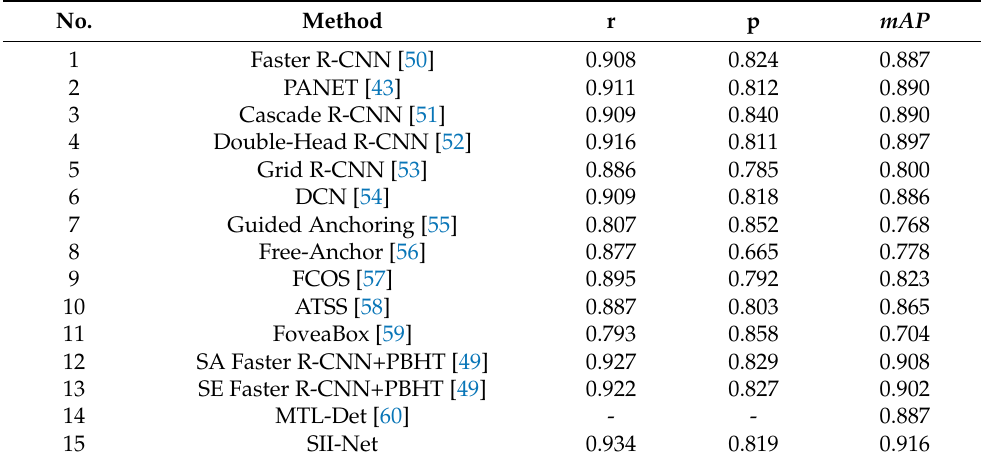
Table 5. Evaluation indices comparison with the other methods on LS-SSDD-v1.0 of the offshore